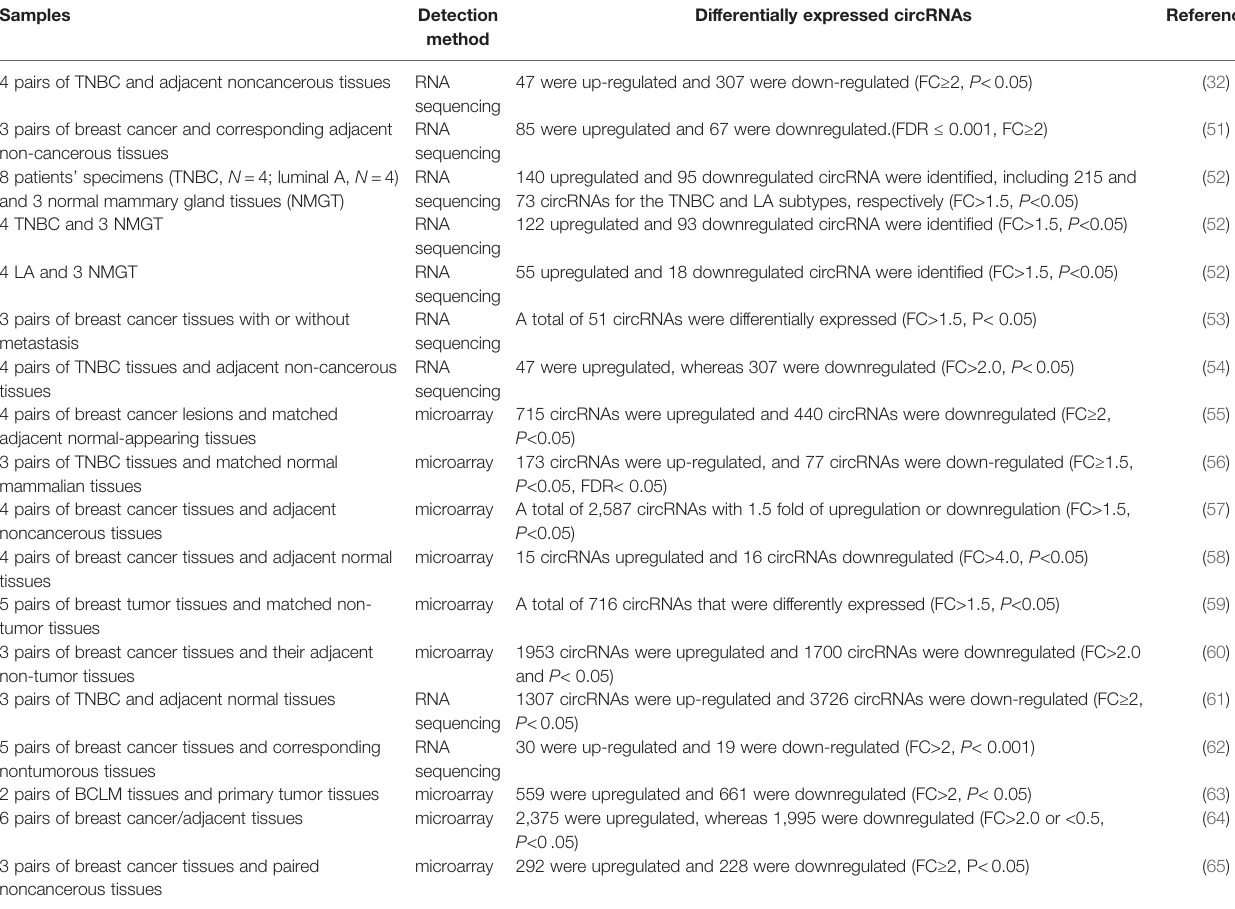
TABLE 1 | RNA sequencing and microarray analyses of differentially expressed circRNAs in breast cancer.